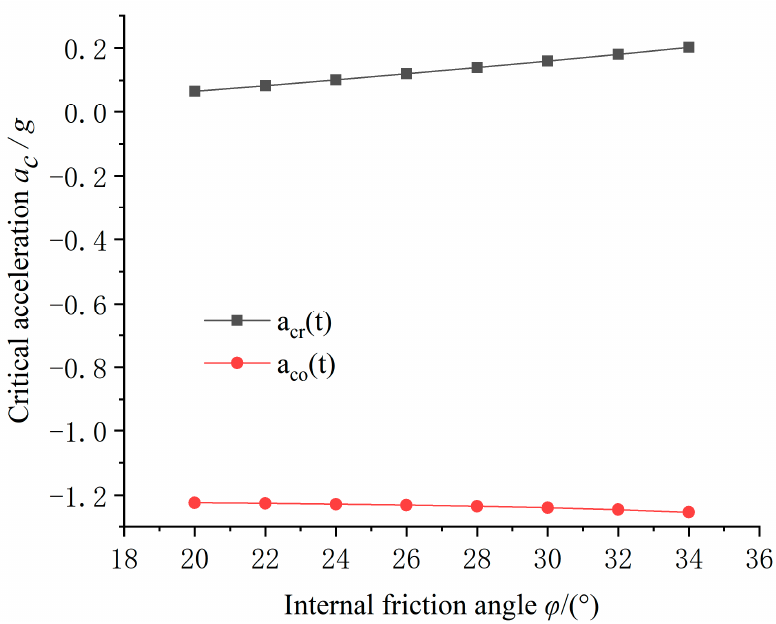
Figure 9. Influence of internal friction angle of soil φ on critical acceleration a c.